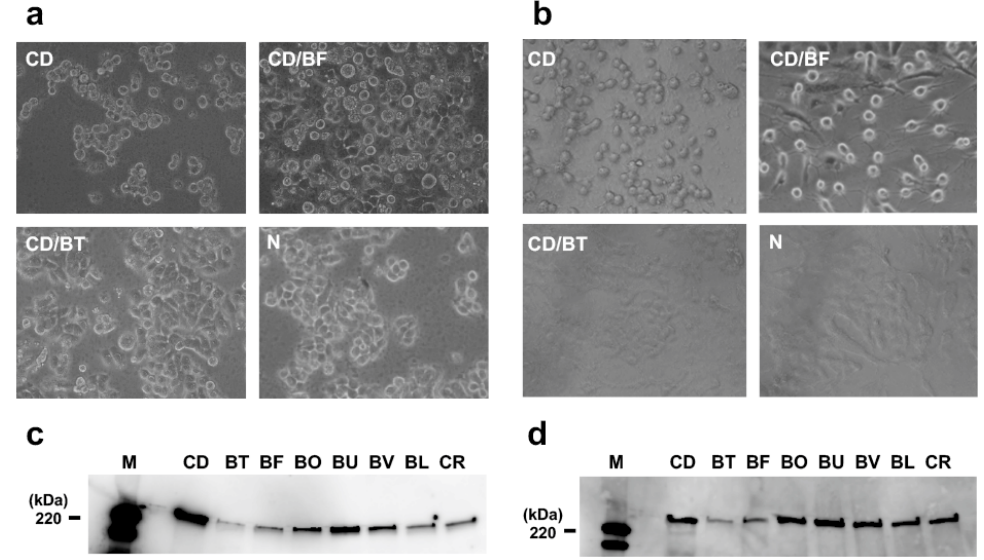
Figure 1. Effect of Bacteroides species on Clostridium difficile (CD) toxin production. Cytopathic effect by CD toxins A and B in the culture supernatants were evaluated by a cytotoxicity assay using ( a ) human colon cancer cell line HT-29 cells and ( b ) Vero cells. CD, CD ATCC9689; CD/BF, co-culture of CD ATCC9689 and B. fragilis YCH46; CD/BT, co-culture of CD ATCC9689 and B. thetaiotaomicron VPI-5482; and N, GAM broth only. Western blotting of the cell-free CD supernatants in the conditioned media with either ( c ) anti-Toxin A or ( d ) anti-Toxin B antibody. CD, CD ATCC9689 culture supernatant in GAM broth; conditioned medium containing 50% ( v / v ) culture supernatant of BT, B. thetaiotaomicron VPI-5482; BF, B. fragilis YCH46; BO, B. ovatus ATCC8483; BU, B. uniformis ATCC8492; BV, B. vulgatus ATCC8503; BL, Bifodobacterium longum JCM1217; and CR, Clostridium ramosum JCM1298. M, HPR-labelled protein size marker.